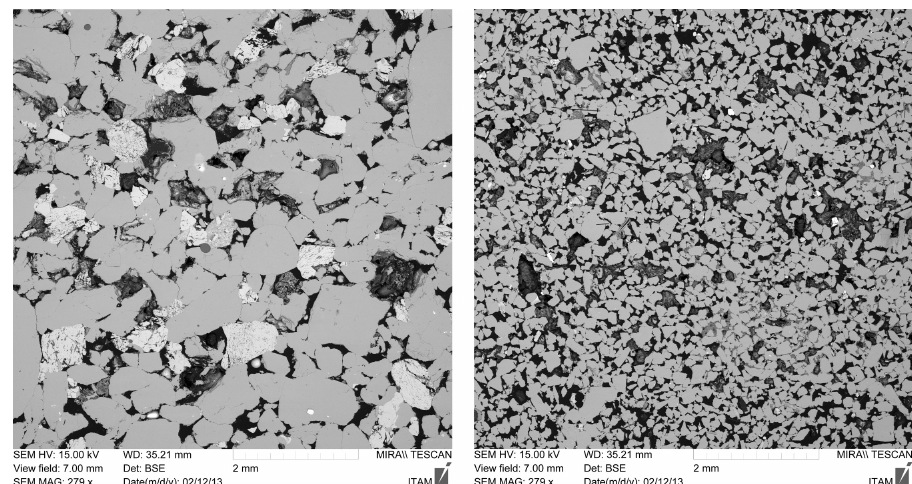
Figure 4. Arkose from the Charles Bridge (left) and Petřín sandstone (right) captured using BSE detector in